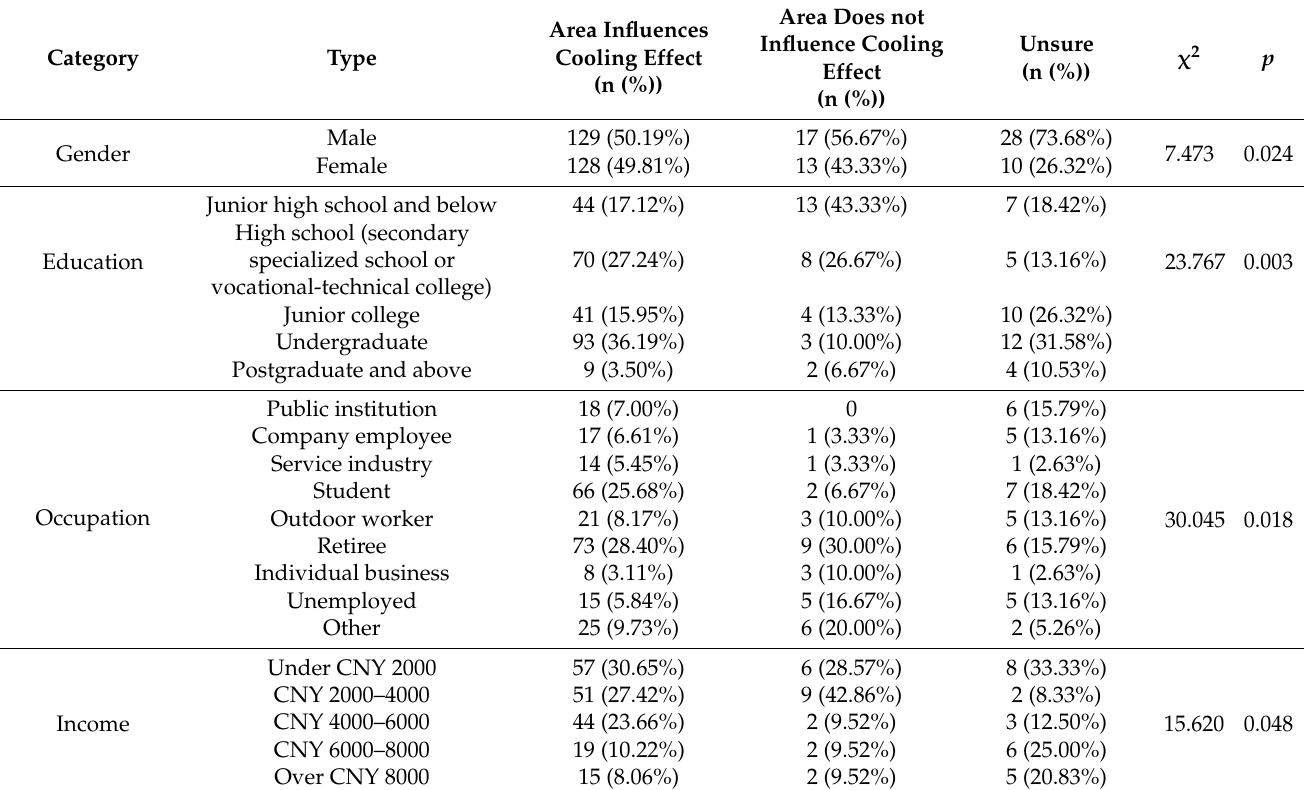
Table 5. Test on the influence of area on cooling effect for different groups of people.